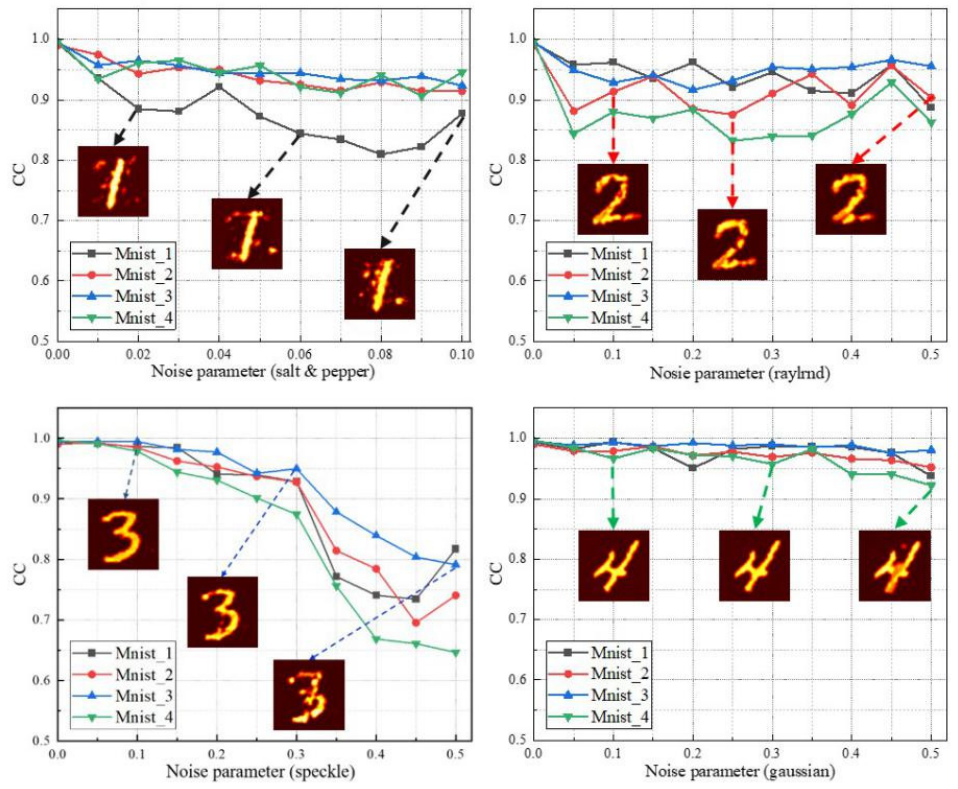
Figure 11. The CC curve of the decryption results after adding different noise attacks to the ciphertext. For Gaussian noise and speckle noise, the abscissa represents the variance